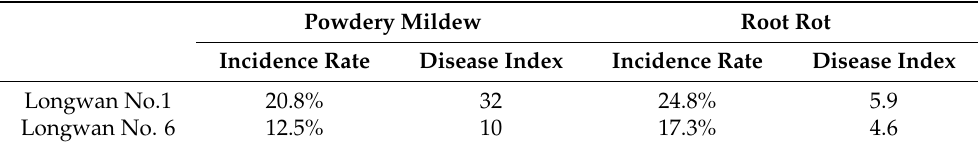
Table 3. Analysis of disease resistance in Longwan No. 6 pea cultivars.